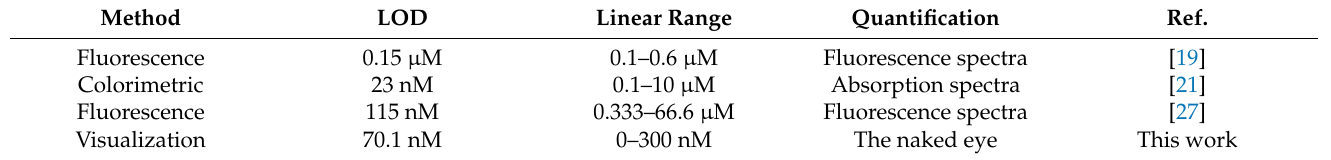
Figure 4. Cu 2+ detection on the microfluidic chip. ( a ) Optical image showing the accumulating PMPs under different Cu 2+ concentrations. ( b ) The trapping length (mean ± maximum deviation, n = 3) corresponding to ( a ). ( c ) The linear relationship between the trapping length and the Cu 2+ concentration. Table 1. The comparison between this work and recently reported Cu 2+ detection works.